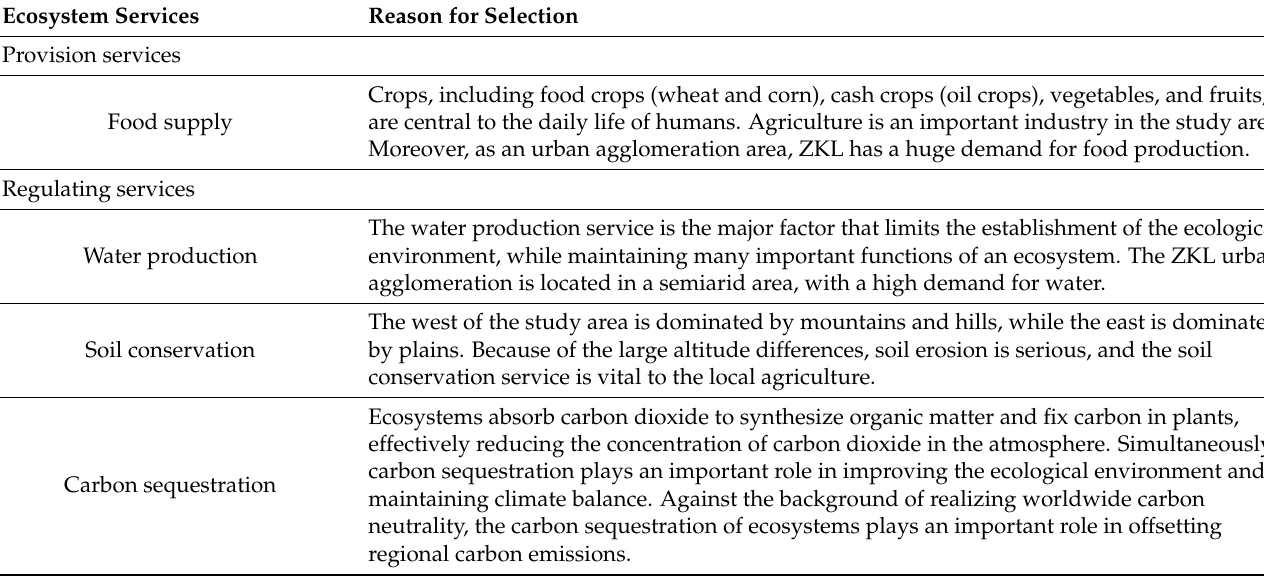
Table 2. Criteria for selecting key